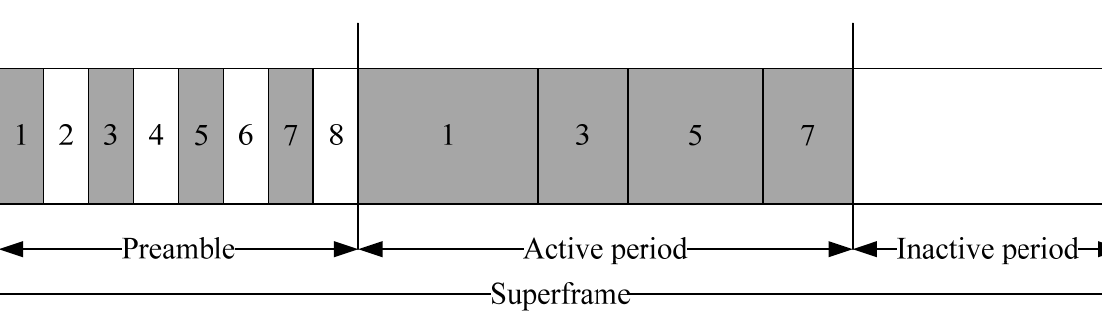
Figure 7. PB-TDMA superframe